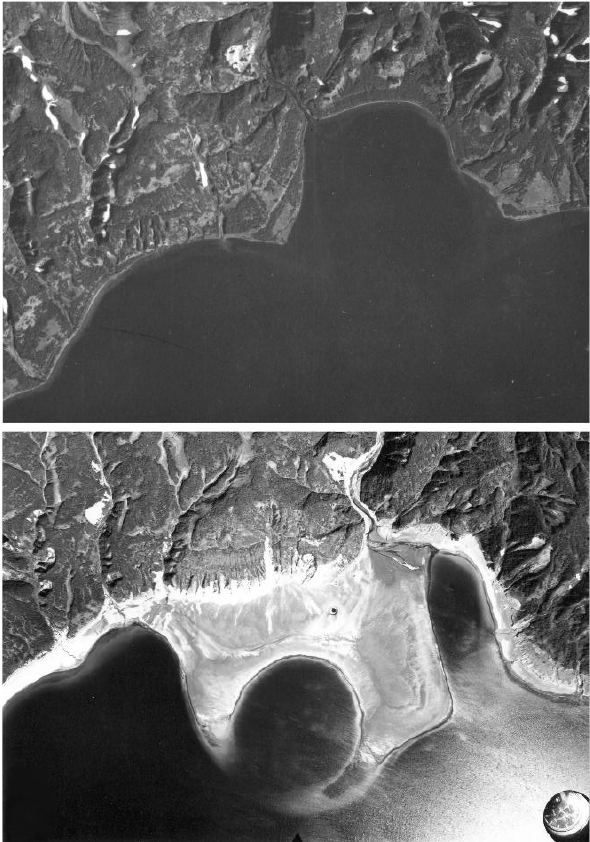
Fig. 3. Vertical aerial photographs of the 1996 eruption site in the northern part of Karymskoye lake. The upper photo shows the pre- eruption coastline (1984), and the lower photo shows the coastline after the eruption (August 1996). Images courtesy of Institute of Volcanology and Seismology,